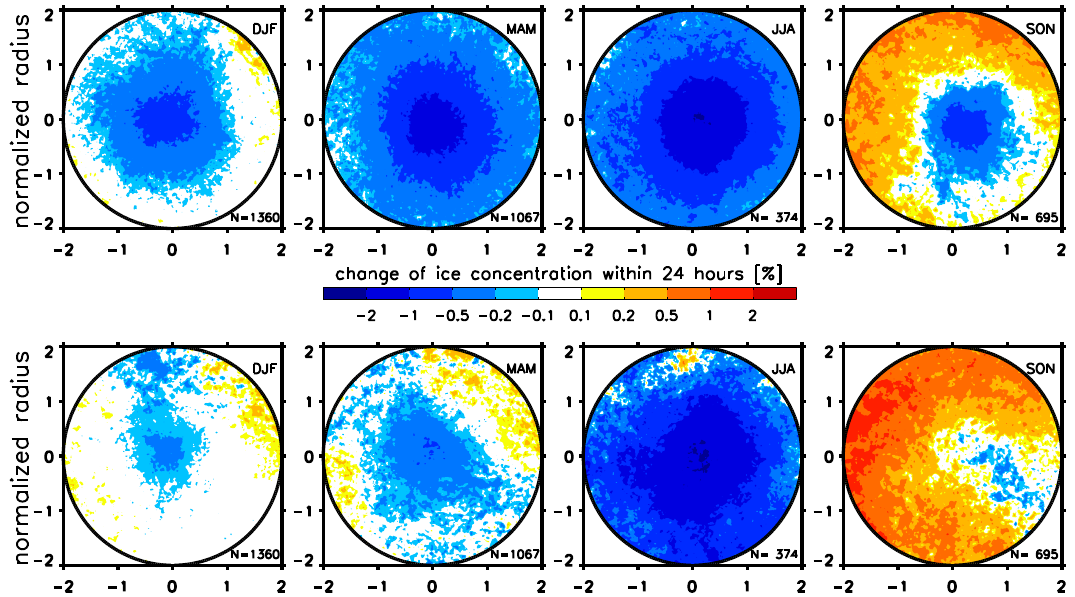
Fig. 11. Mean change of simulated (top) and AMSR-E (bottom) ice concentration within 24h after cyclone passage ( t = 0) for each season.